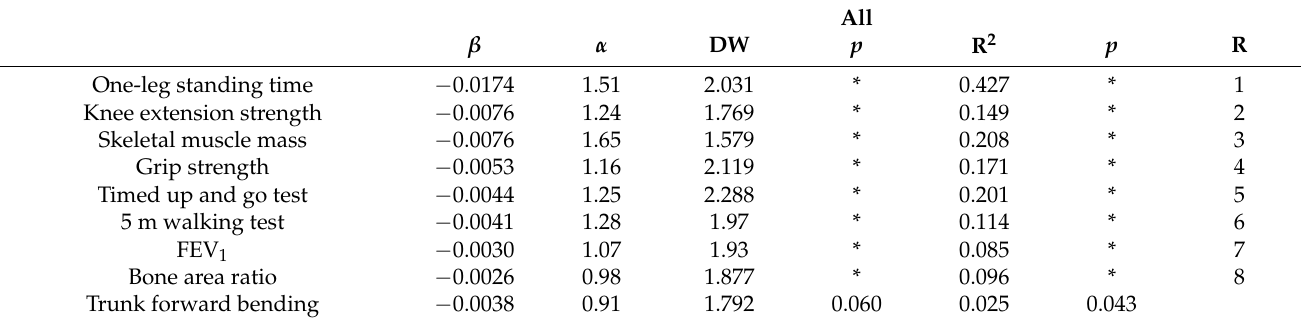
Table 2. Comparison of the rate of decline in each physical function in all subjects.